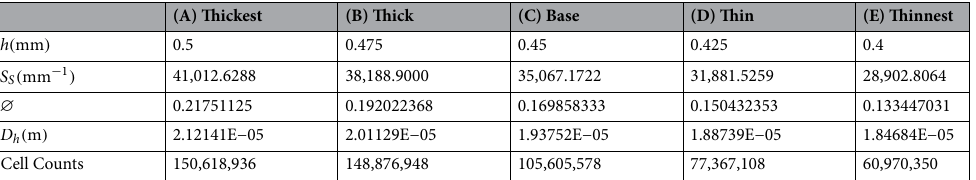
Table 2. Summary of geometric variables of the five multi-size pack models. Ref: grid resolutions (minimum and maximum face-area and cell-volume) were changed to several models owing to convergence issue.